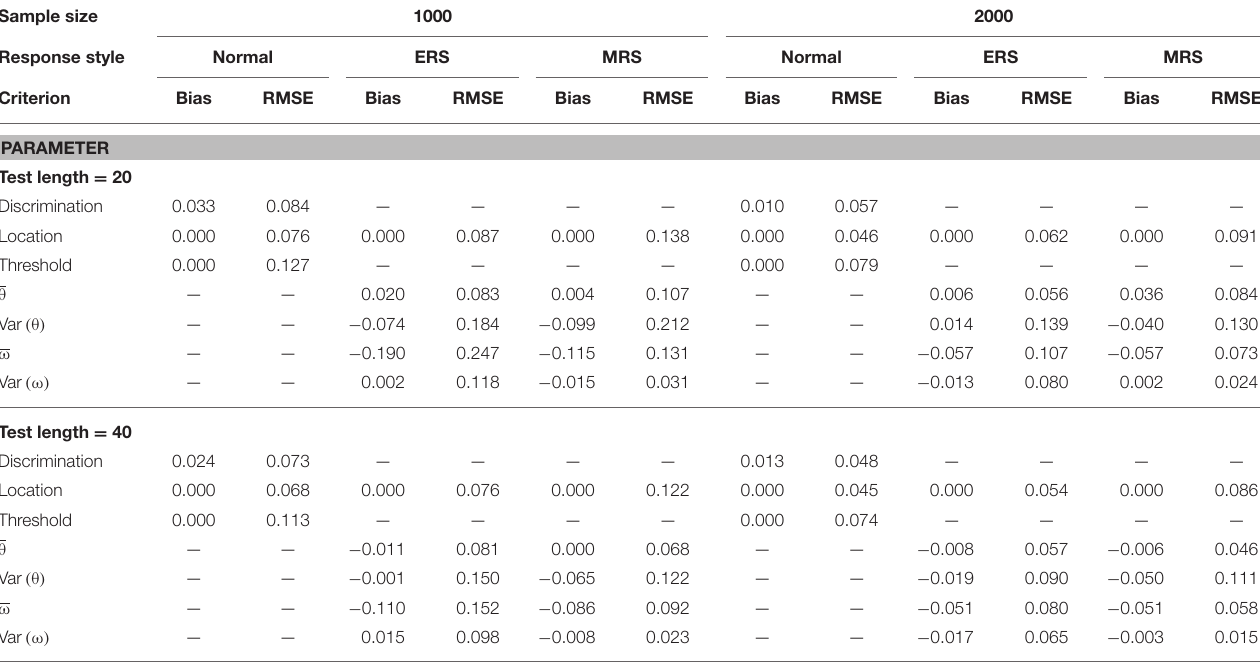
TABLE 2 | Mean bias and RMSE of the model parameter estimates for the mixture ERS-GPCM on 6-point items. Sample